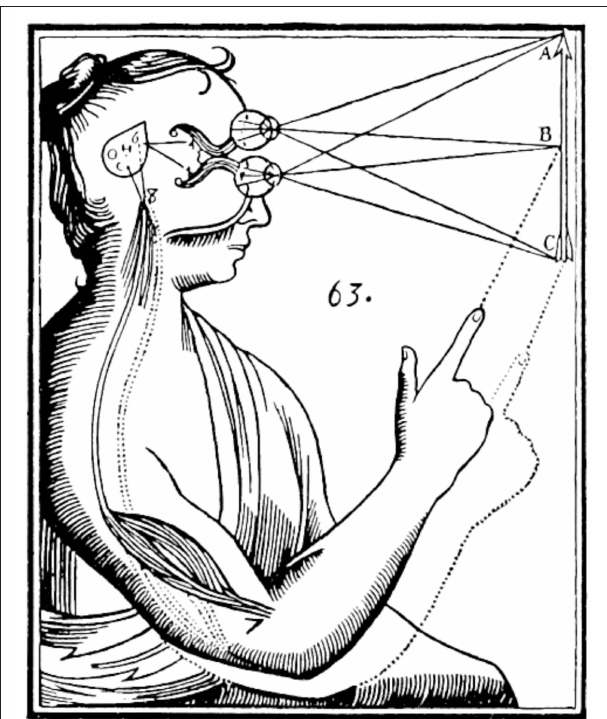
FIGURE 1 | Illustration from Descartes (1662) visualizing the difference between physical objects (upper right corner) and their epistemic representations (upper left